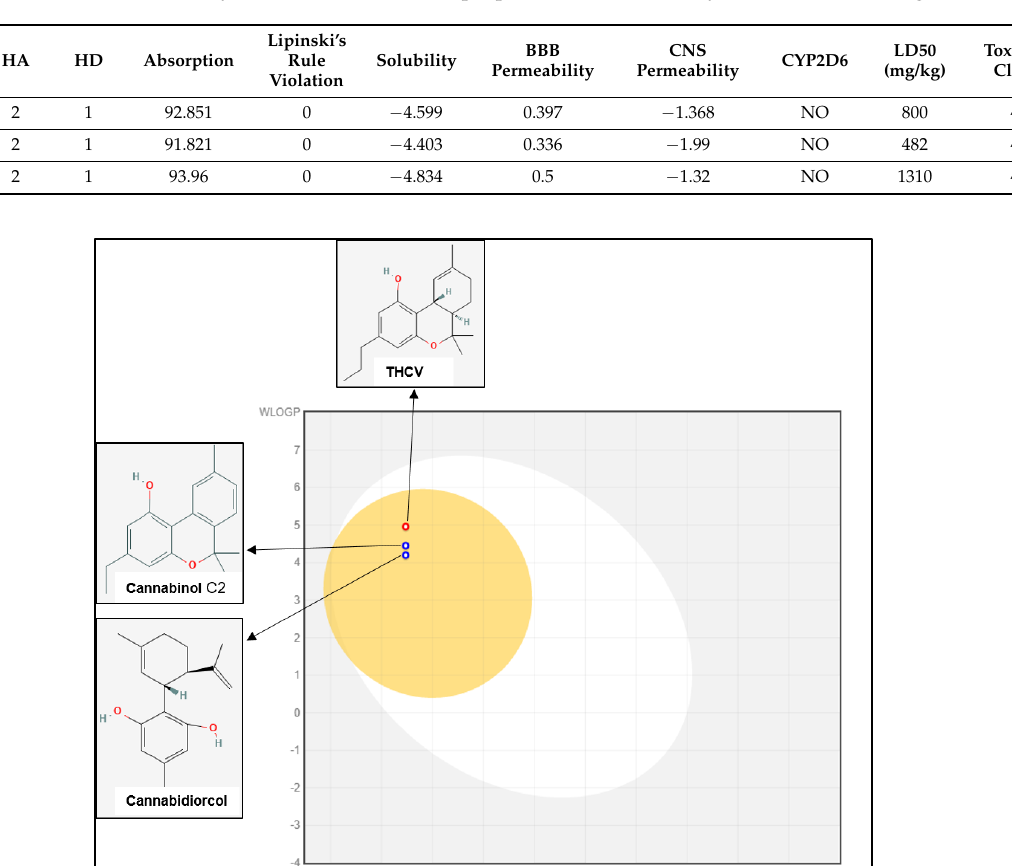
Table 2. Analysis of Pharmacokinetic properties and Protoxicity of three CBD analogues.